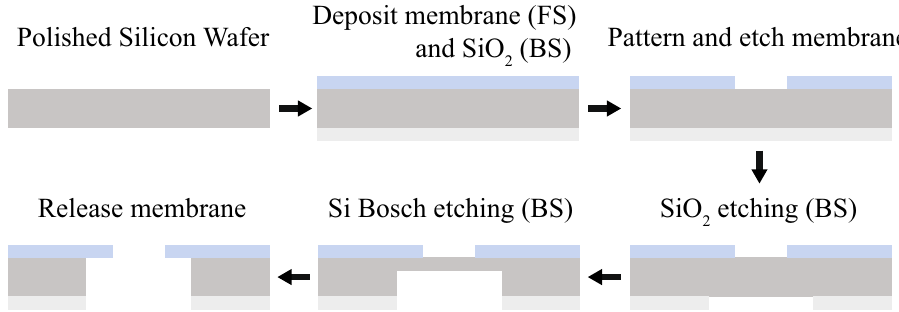
Figure 2. Membrane fabrication process of SiN and AlN; FS is the front side, the top of a silicon wafer, and BS is the back side, the bottom of a silicon wafer. The thickness of membranes is 200 nm, and the membrane transmittance is greater than 95% at 852 nm wavelengths (laser cooling light for Cs